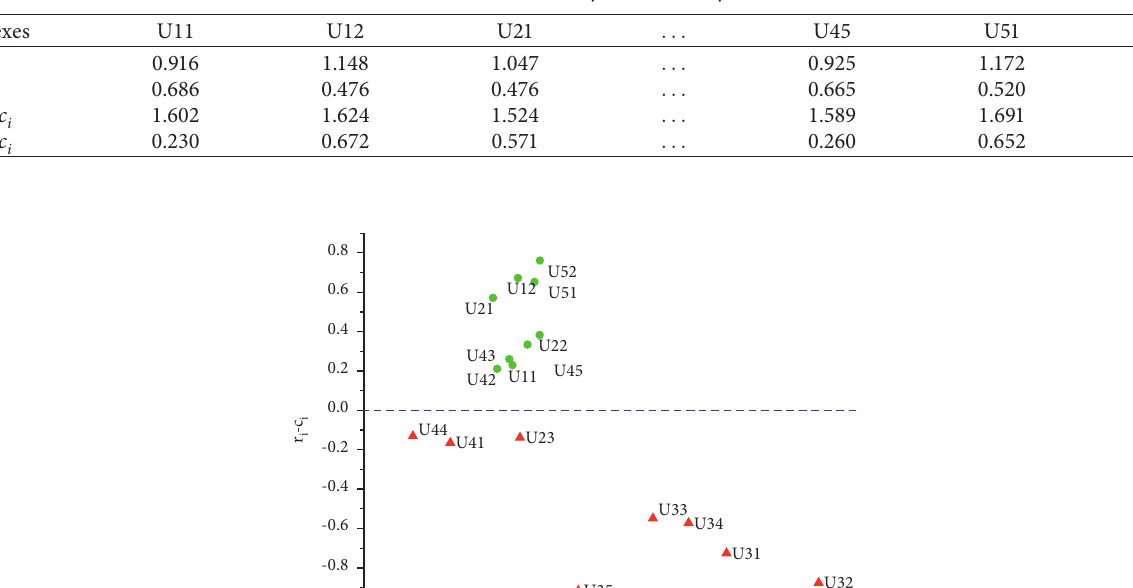
Table 4: Centrality and causality.